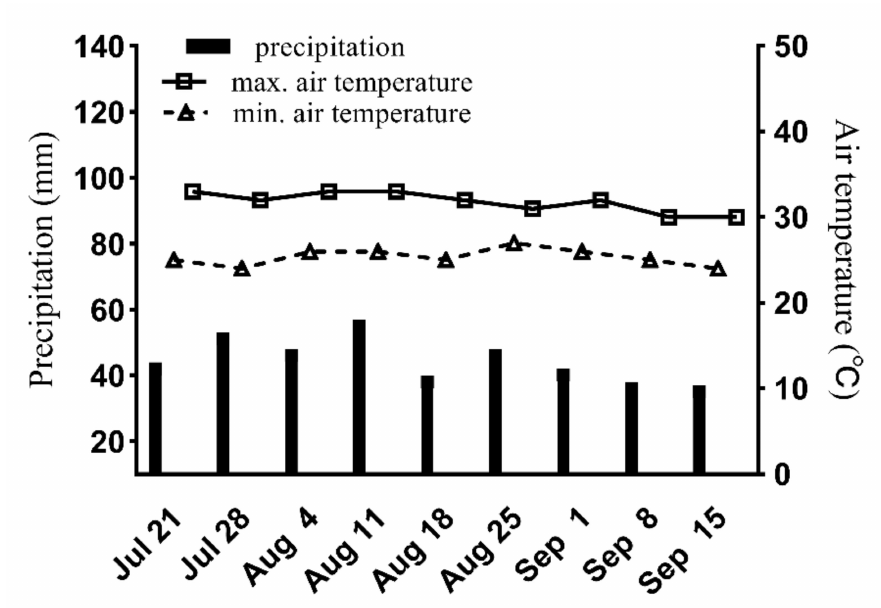
Figure 1. Weekly average minimum and maximum air temperatures and weekly rainfall during experiment: year